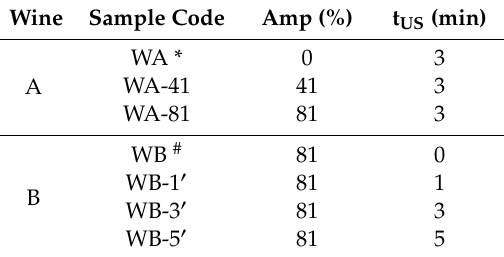
Table 2. Experimental ultrasound